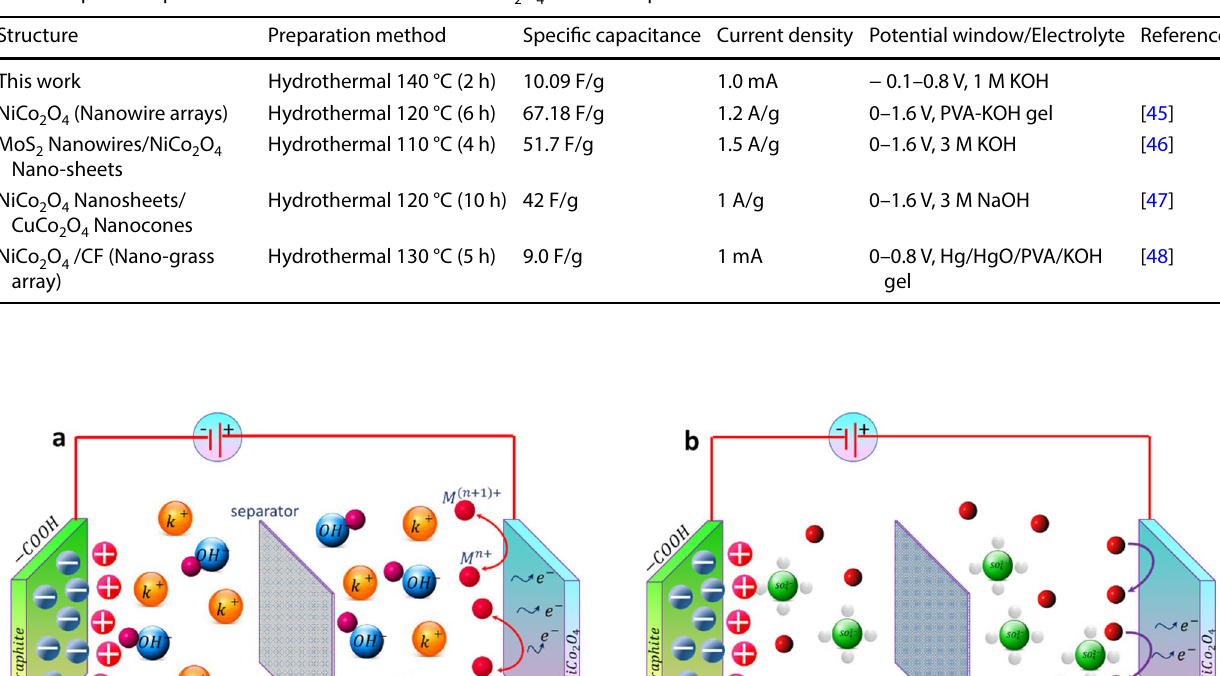
Fig. 8 Galvanostatic charge–discharge curves of a NiCo aqueous electrolyte solution